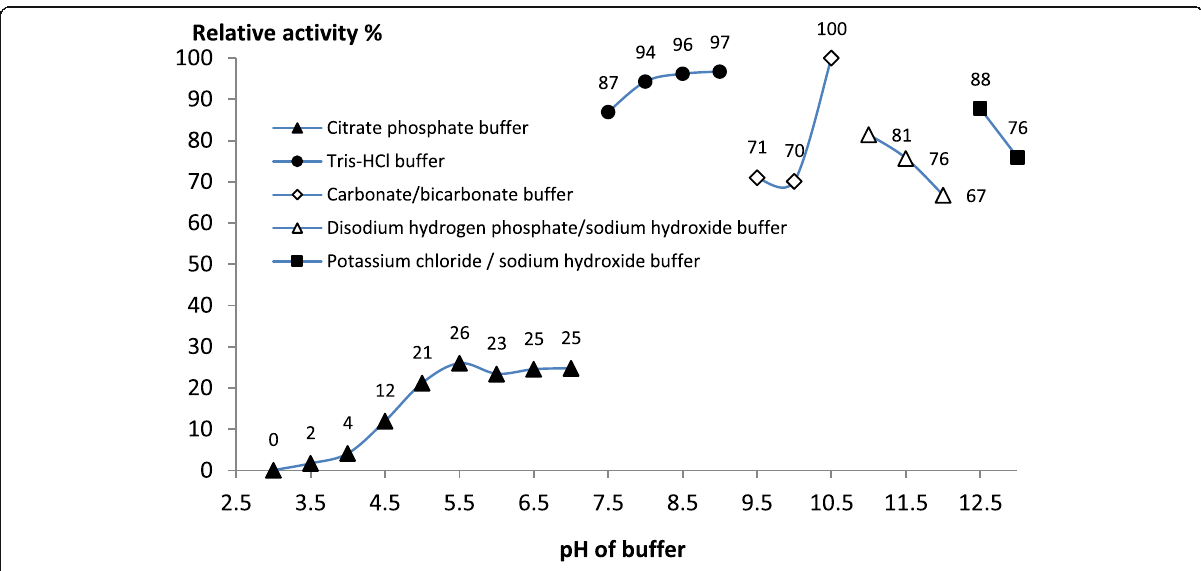
Fig. 1 Relative activity of Streptomyces sp. SBLWN_MH2 lipase at different buffered pH